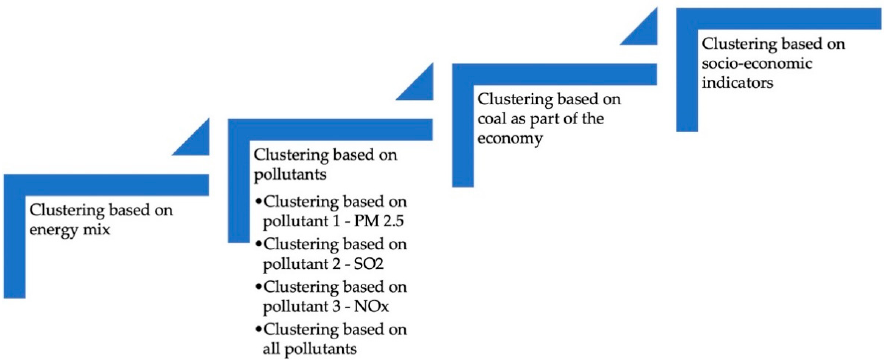
Figure 3. Steps of the cluster analysis.